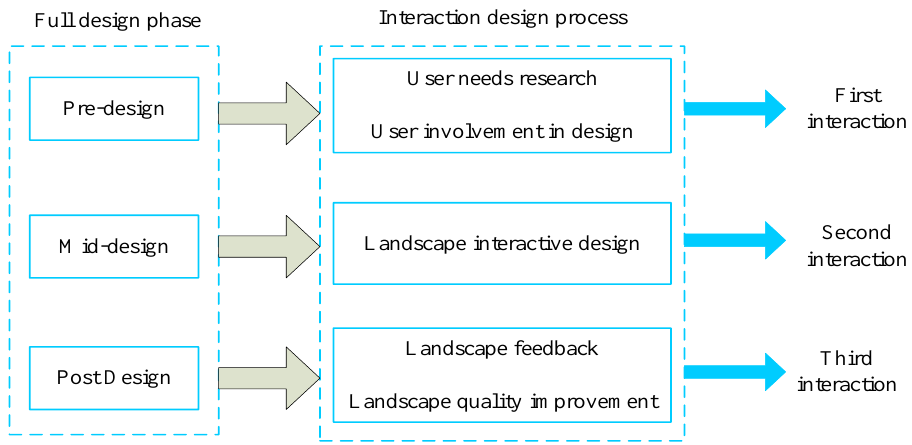
Figure 13. Three processes involved in interaction design.